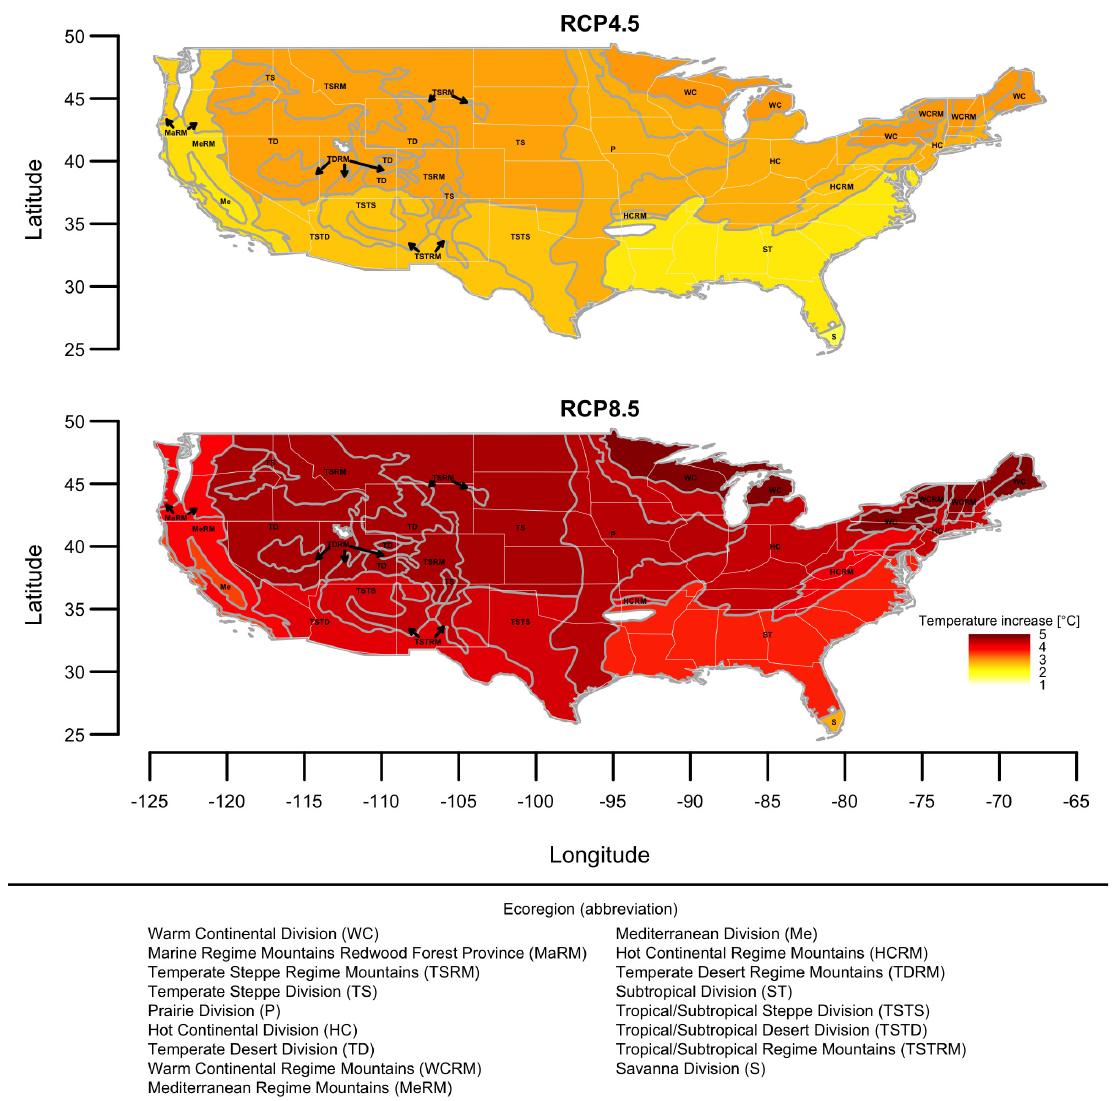
Figure 1. Map of multi-model mean temperature changes between 1955–2005 and 2050–2099 over the relevant Bailey’s divisions under the representative concentration pathway (RCP) 4.5 (top) and RCP 8.5 emission scenarios (bottom). Regions with insufficient fire occurrence data for analysis are colored